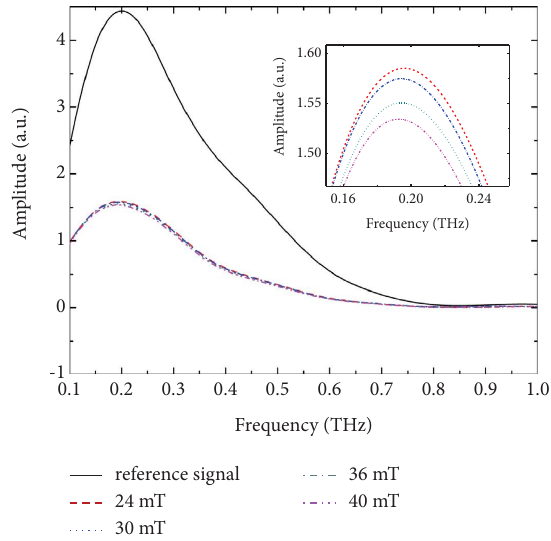
Figure 11: THz frequency-domain spectra of MWCNT aqueous dispersion under diferent MF